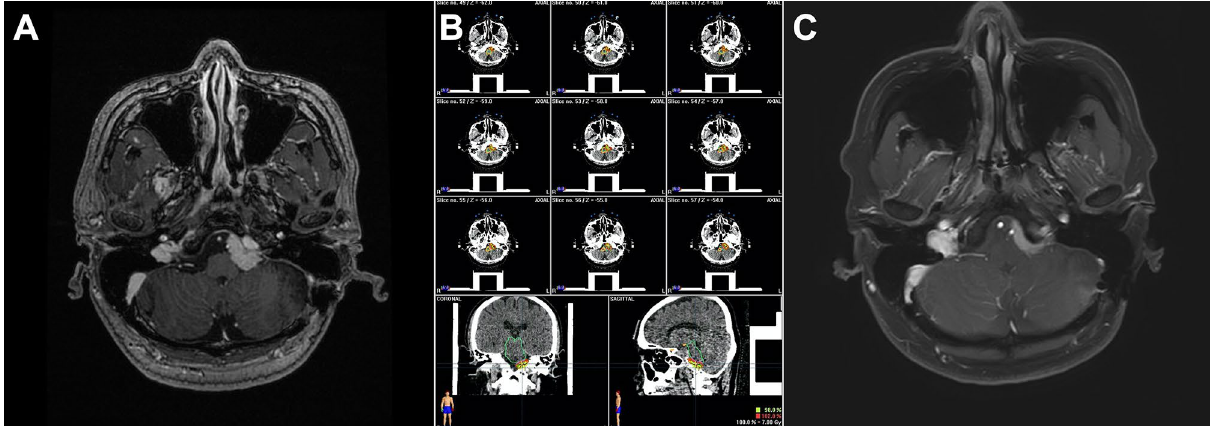
Figure 1. A 48-year-old male with a petroclival meningioma (volume, 3.02 ml). Treatment was 21 Gy in three fractions. ( A ) Pre-treatment magnetic resonance imaging (MRI) scan. ( B ) Treatment plan showing the resulting isodose line. ( B ) MRI scan 36-months after treatment showing tumor regression.